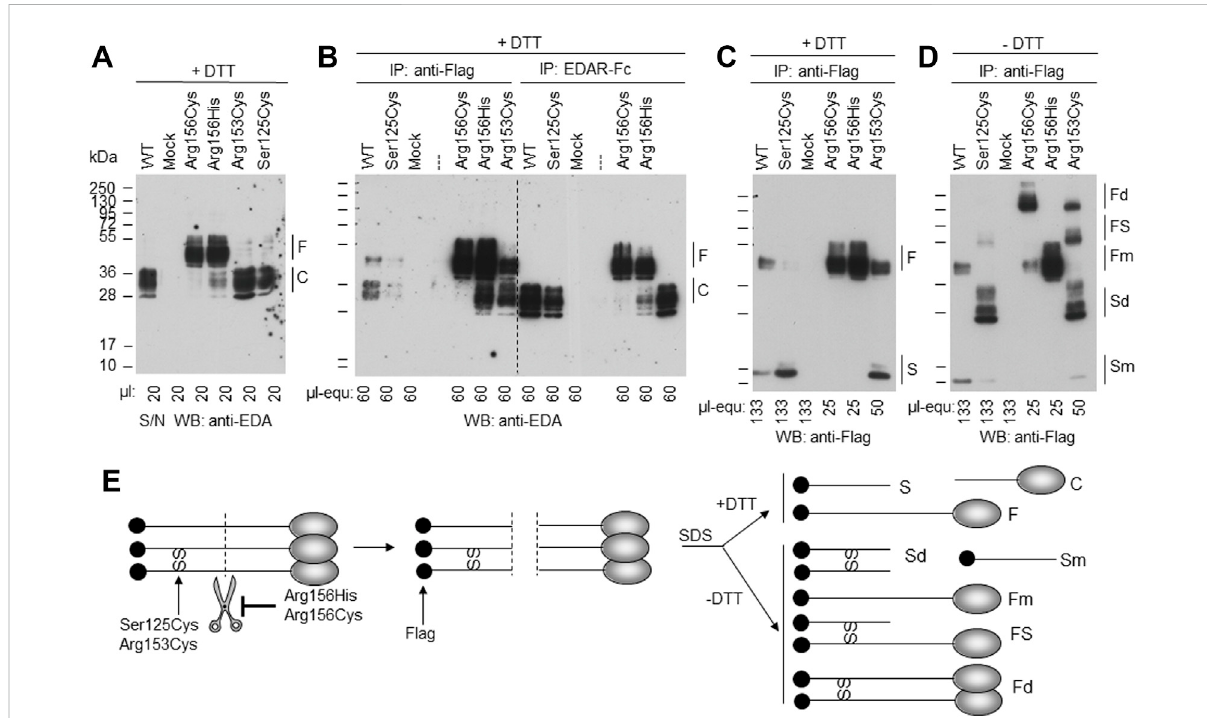
FIGURE 6 EDA1-Ser125CysissecretedandprocessedattheFURasef fi cientlyasWTbutinducesformationofdisul fi debridges.Conditionedsupernatants (S/N) of HEK 293T cells transiently expressing a soluble form of Flag-EDA (starting as Ser66 after the TM), with or without XLHED-causing variants in thestalkregionorFUR,wereeitheruseddirectlyorimmunoprecipitatedwithimmobilizedanti-FlagmAborwithimmobilizedEDAR-Fc.Thesamples were analyzed by WB with either anti-EDA mAb Renzo-2 or anti-Flag mAb M2 as indicated. Renzo-2 and M2 recognize the C-terminal and N-terminal portions oftheconstructs, respectively. (A) Cell supernatantsanalyzed byWestern blotwithanti-EDAunderreducing(+DTT) conditions. (B) Cell supernatants analyzed by WB with anti-EDA under reducing (+DTT) conditions after immunoprecipitation with anti-Flag or with EDAR-Fc. The amount loaded is indicated as µl equivalent of conditioned medium (µl-equ). (C) Same anti-Flag immunoprecipitation as shown in panel B, except that the blot was revealed with anti-Flag and that amounts loaded in each lane were adjusted as indicated. (D) Same as panel C, but with samples that were not reduced (- DTT). (E) Schematic drawing of EDA with N-terminal Flag tag (black circle) and C-terminal receptor-binding domain (gray ovals forming 3-mers under native conditions, according to protein data bank entry 1RJ7). Scissors represent furin or furin-like activities. SS represent disul fi de bonds observed in EDA variants p. Ser125Cys, p. Arg153Cys and p. Arg156Cys. Schemes on the left and in the middle representunprocessedand cleavednative EDA,respectively. Schemesontherightrepresentdenatured(SDS)proteininthepresence (+DTT,top)or absence (-DTT, bottom) of reducing agent to yield fragments with or without disul fi de bonds. F, full length; C, cleaved; S, stalk; Fd, disul fi de-linked dimer of full EDA; FS, full EDA disul fi de-linked to a stalk; Fm, non-disul fi de-linked monomer of full EDA; Sd, disul fi de-linked dimer of stalk; Sm, non- disul fi de-linked monomer of stalk; SS, inter-chain disul fi de